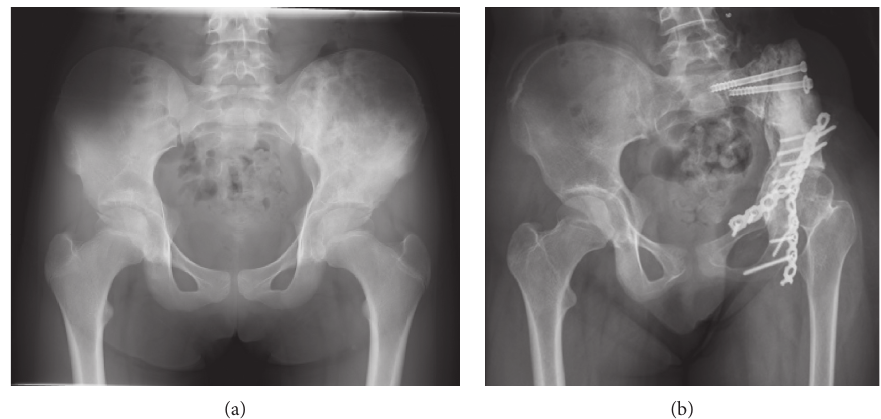
Figure 6: Case #19:11-year-old male with Ewing sarcoma of the left pelvis. (a) Preoperative X-ray. (b) 6 years after radiograph of treatment with osteoarticular extracorporeal irradiated autograft. Osteonecrosis of the left femoral head occurred with acceptable functional